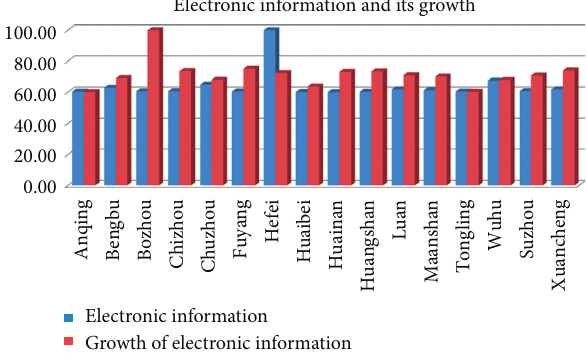
Figure 2: Electronic information and its growth.